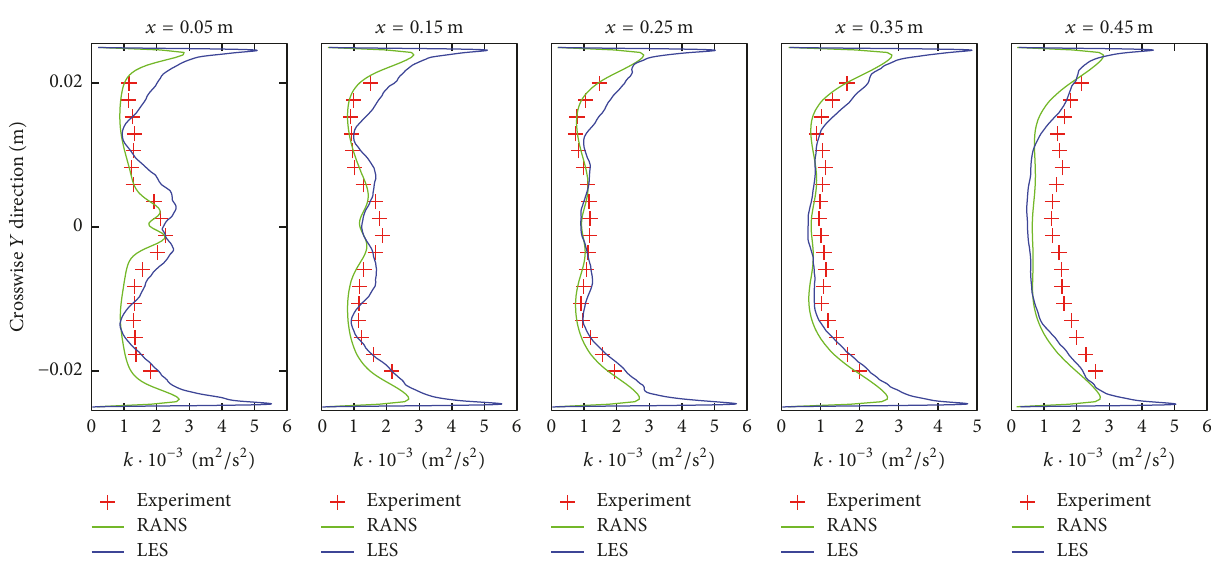
Figure 9: The turbulence kinetic energy profiles at different locations for the single liquid